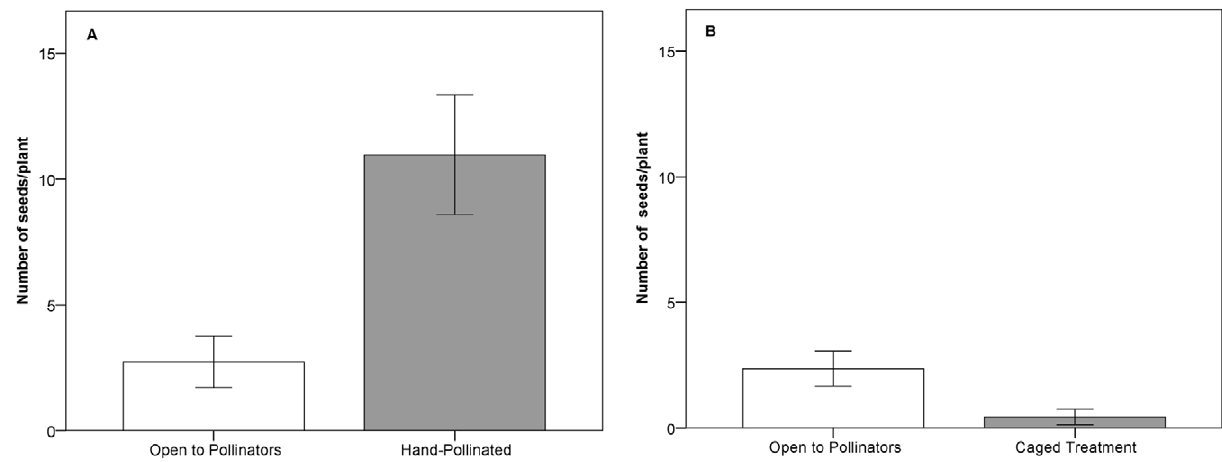
Figure 3. Seeds per plant relative to pollination treatments. 3A. Mean number of seeds per plant in control open to pollinators and supplemental hand pollination treatments in 2010. 3B. Mean number of seeds per plant in open to pollinator control and pollinator excluded (‘‘caged’’) treatments from 2009. Error bars indicate 95% CI.